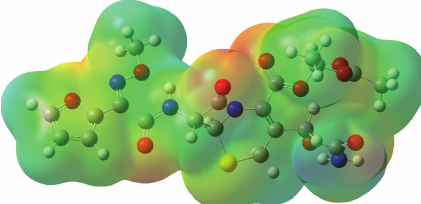
Figure 6: The molecular electrostatic potential of cefuroxime axetil. The positive (blue) regions of the MEP are related to electrophilic reactivity and the negative (red) to nucleophilic